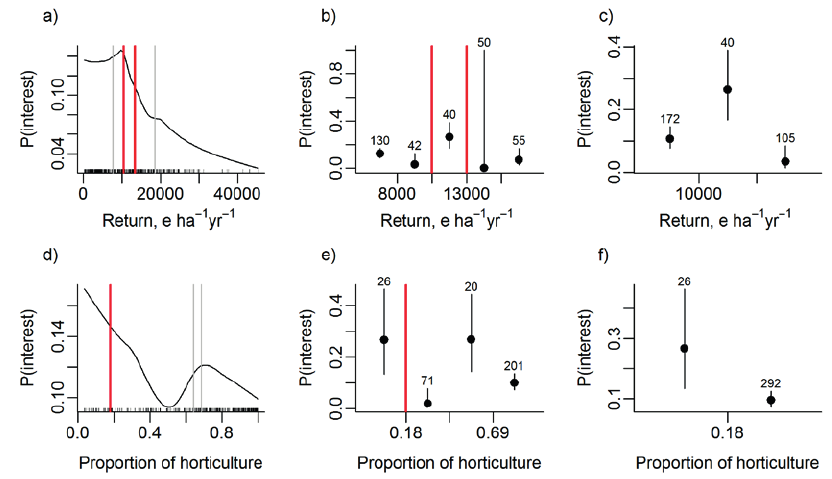
Fig. S5. Probability of interest in organic production as a function of those explanatory variables, which were aggregated using splits (red lines in left and middle panel) chosen subjectively from those suggested by the classification tree (all lines in left